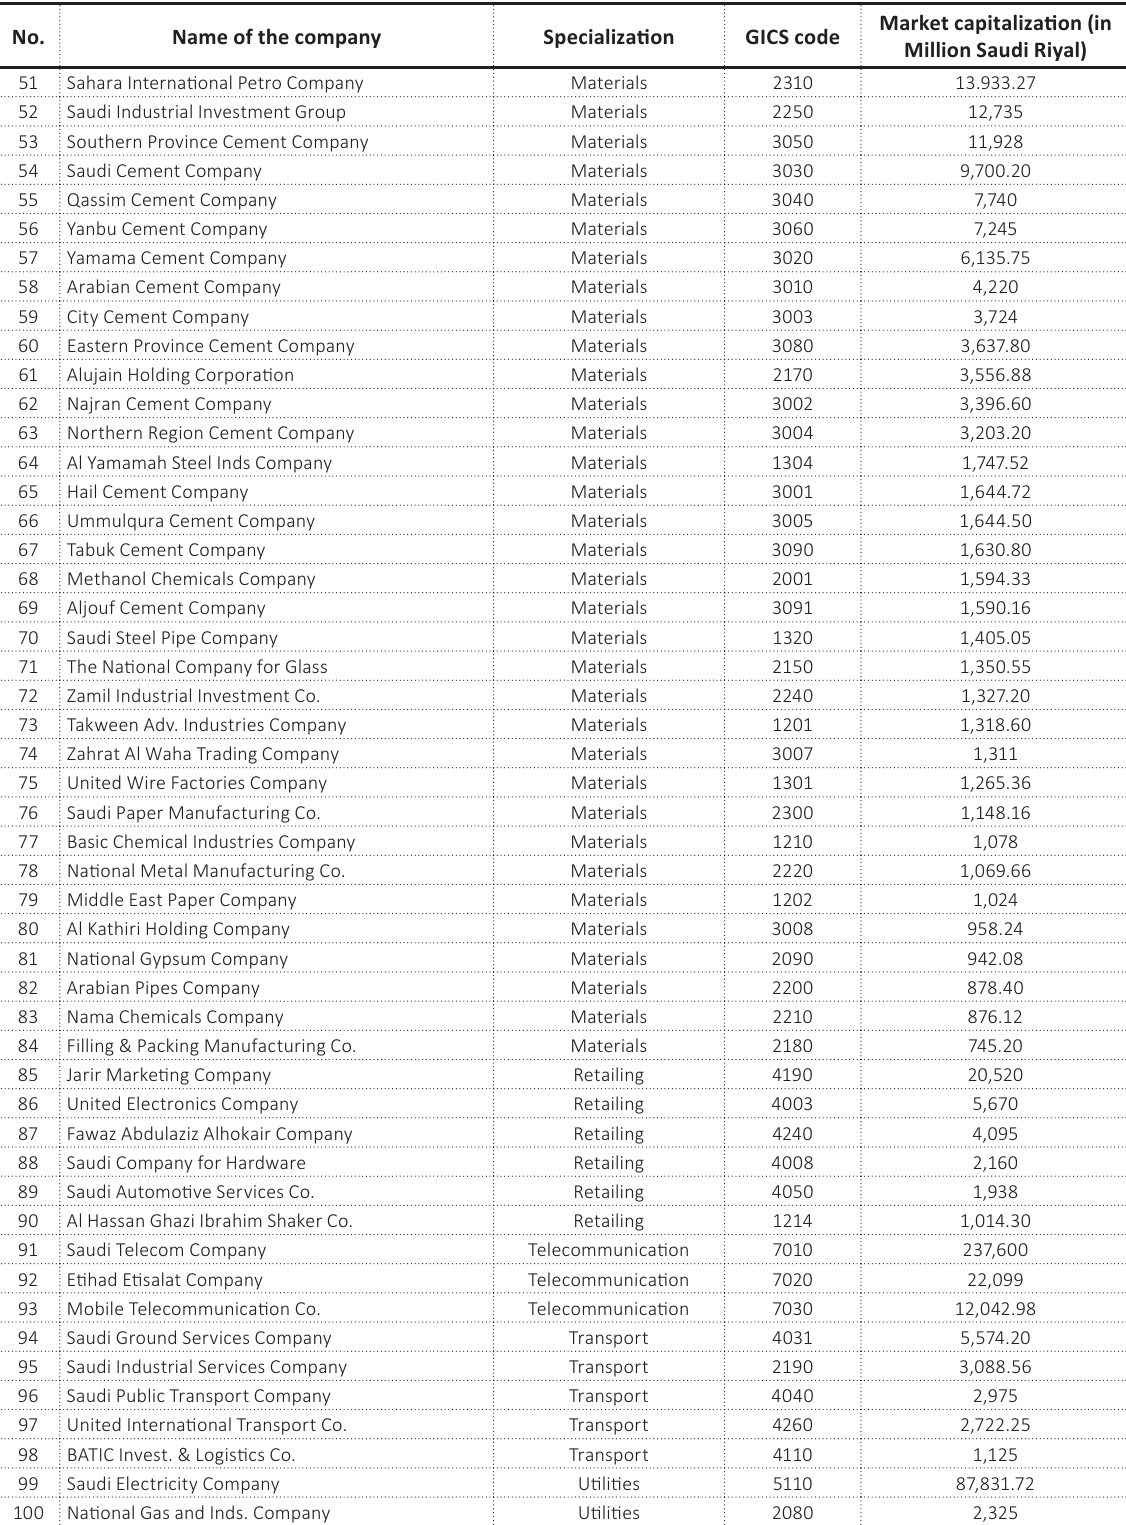
Table A1 (cont.). Companies in the Kingdom of Saudi Arabia according to their specialization, GICS code and market